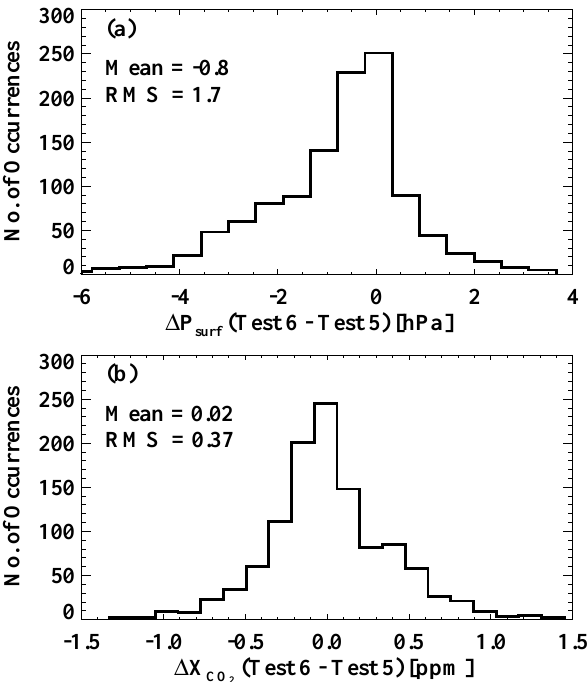
Fig. 11. Distribution of retrieved surface pressure differences (a) and X CO differences (b) between tests 6 and 5, which are due to 2 differences in the a priori meteorology. Only soundings passing the post-processing filters are included.